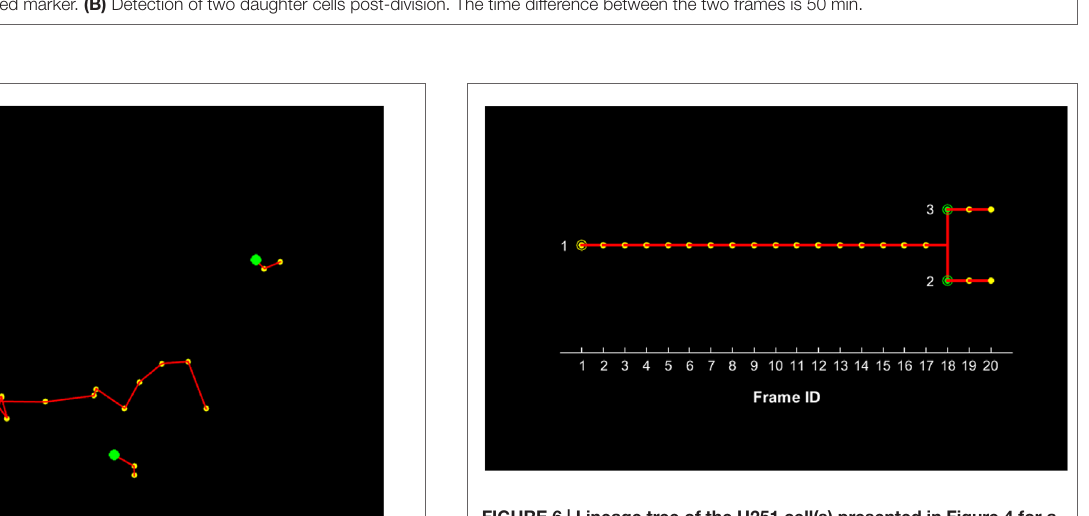
FIGURe 6 | Lineage tree of the U251 cell(s) presented in Figure 4 for a total duration of 20 frames, which corresponds to 3.5 h . The initial parent cell (#1) position is denoted with a yellow circle and its presence is recorded for each subsequent position up to frame #17. After this frame, the parent cell is not recorded and the two daughter cells appear with their first record denoted with green